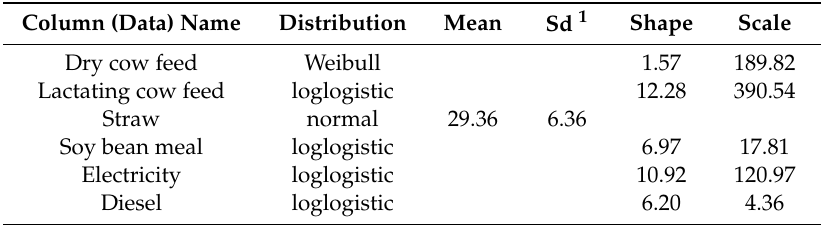
Table 3. Chosen distribution of the data with relevant